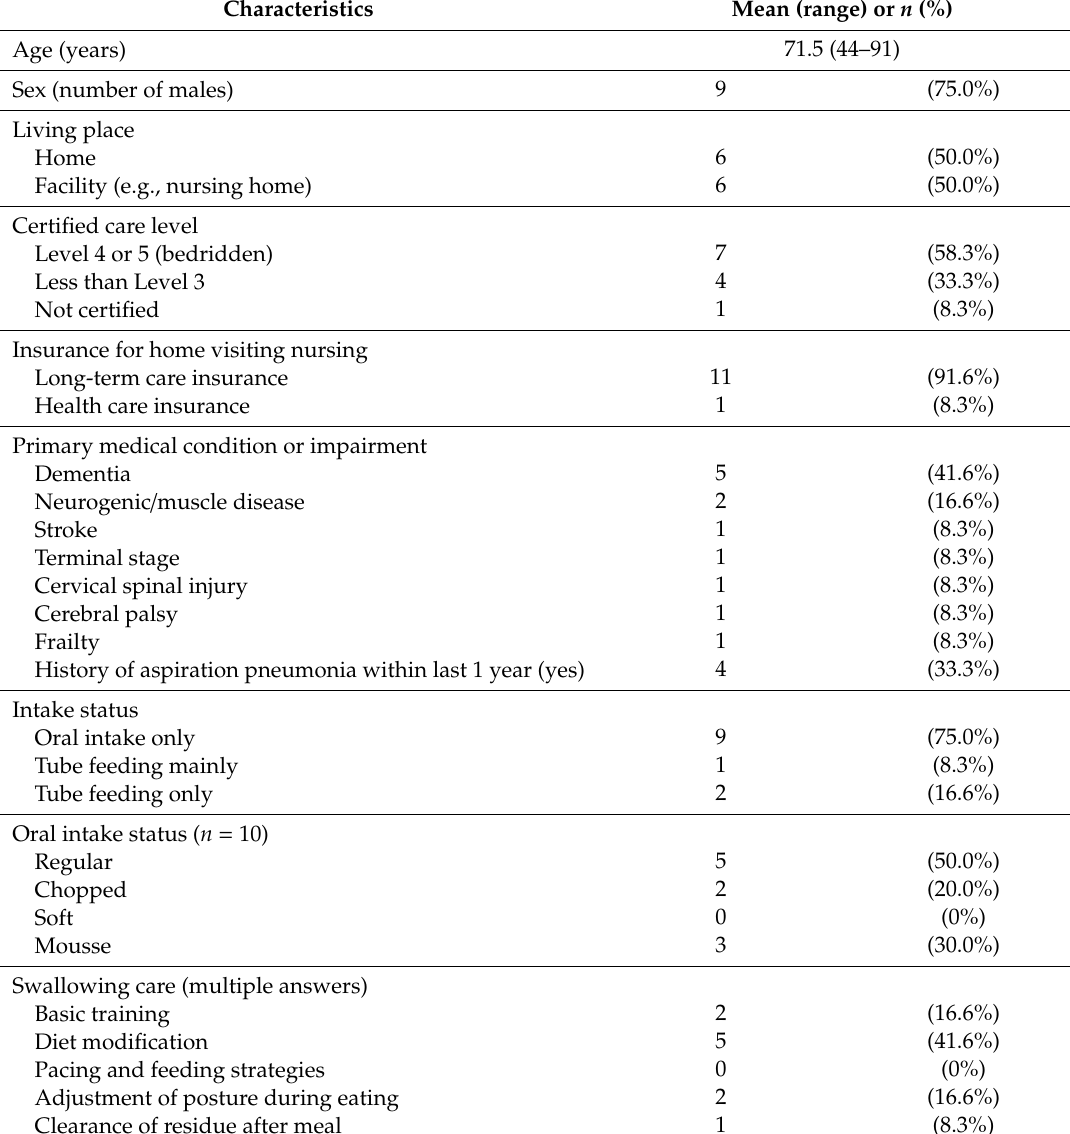
Table 1. Demographic characteristics of patients ( n =